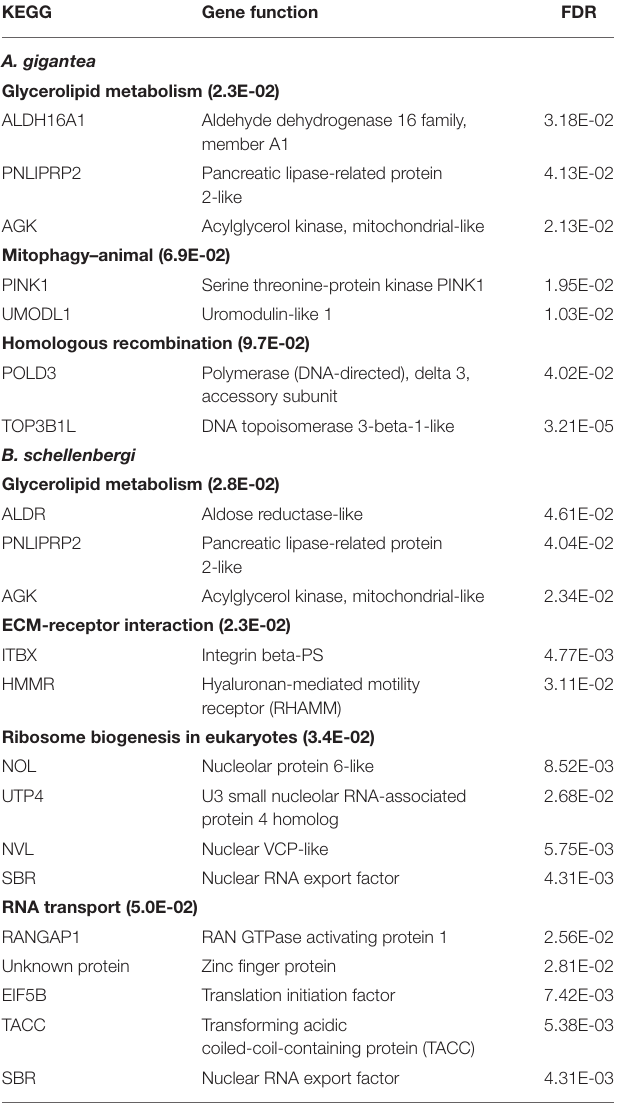
TABLE 1 | KEGG enrichment analysis of the positively selected genes (PSGs) in the hadal amphipods Alicella gigantea and Bathycallisoma schellenbergi